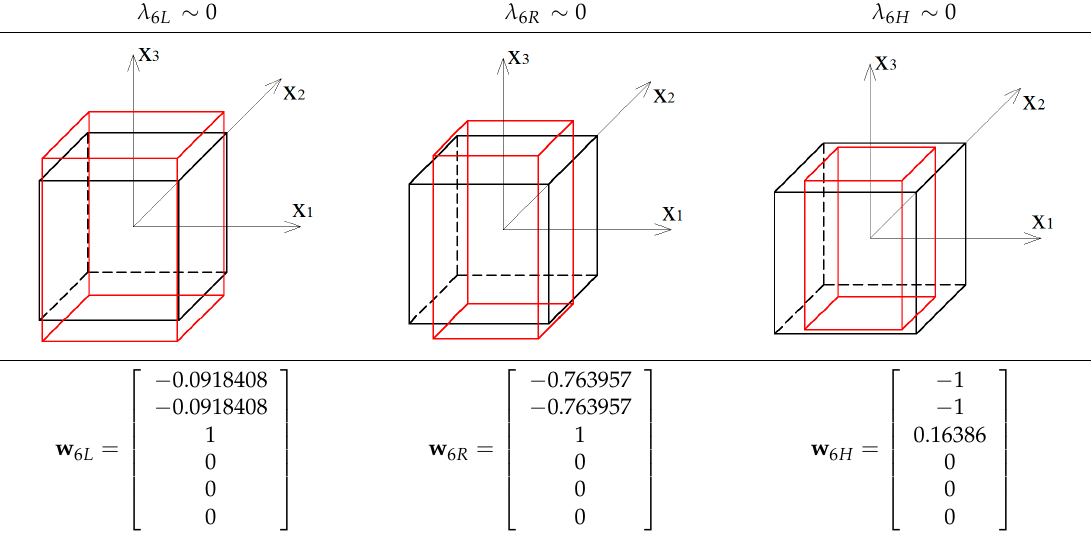
Table 3. Medium extensional mode of deformation.